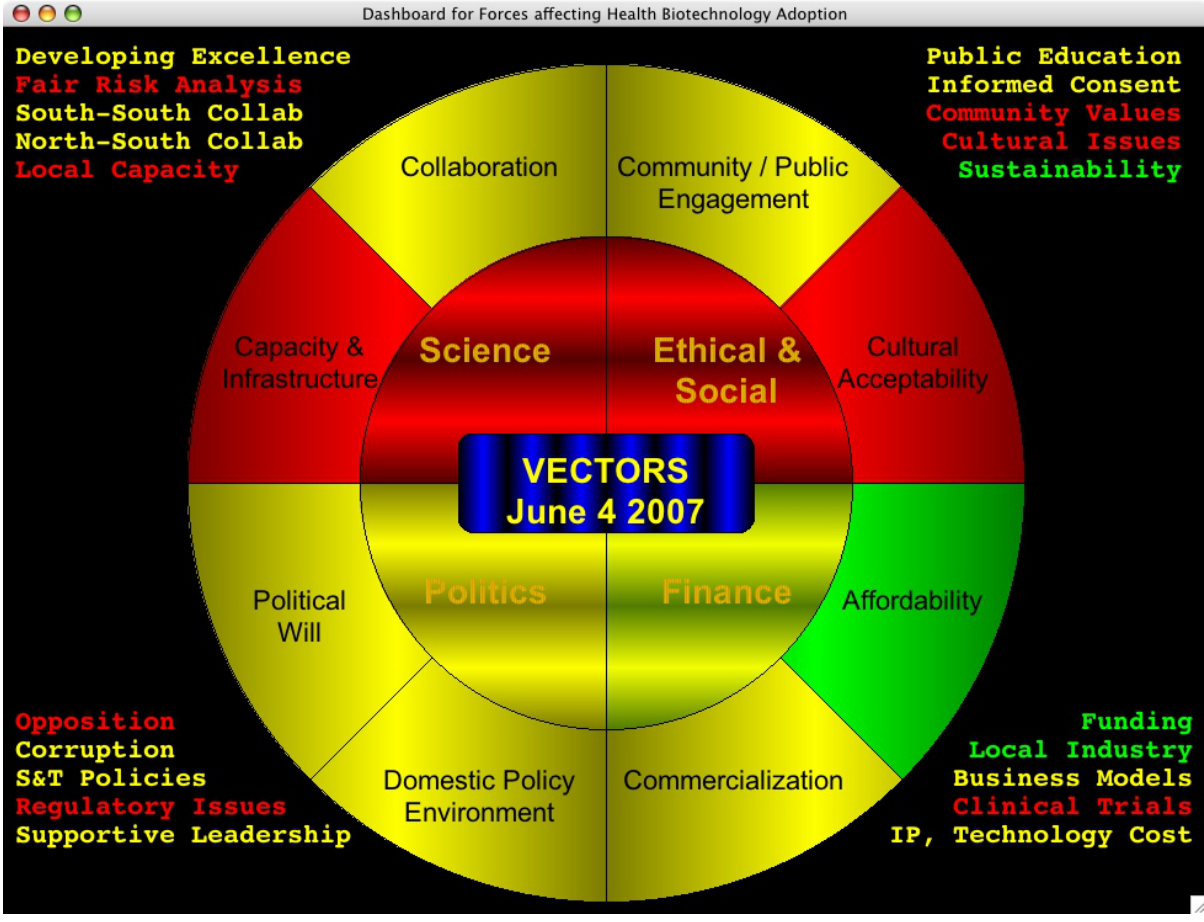
Figure 2. Simulated dashboard for disease